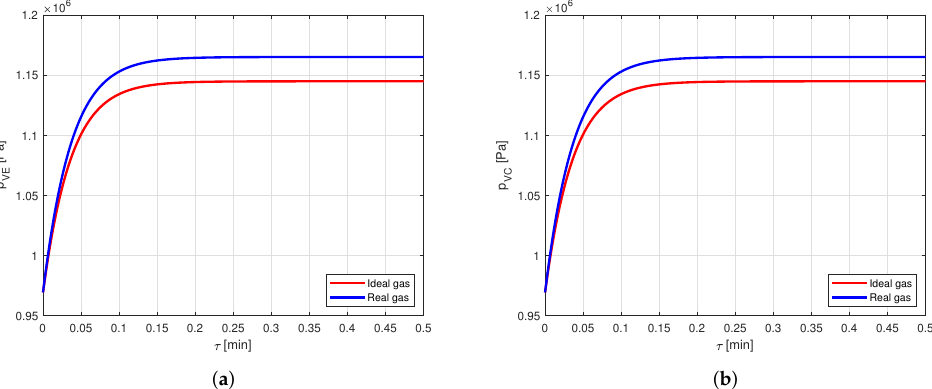
Figure 12. Comparison between the vapor pressures obtained by modeling the vapor as ideal or real gas, in an aluminum-ammonia heat pipe. ( a ) Comparison of the vapor pressures at the evaporator. ( b ) Comparison of the vapor pressures at the